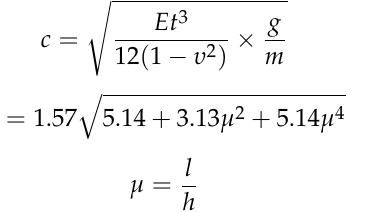
Table 10. Comparison between experimental frequencies and the analytical proposal from Equa- tion (31). Wall